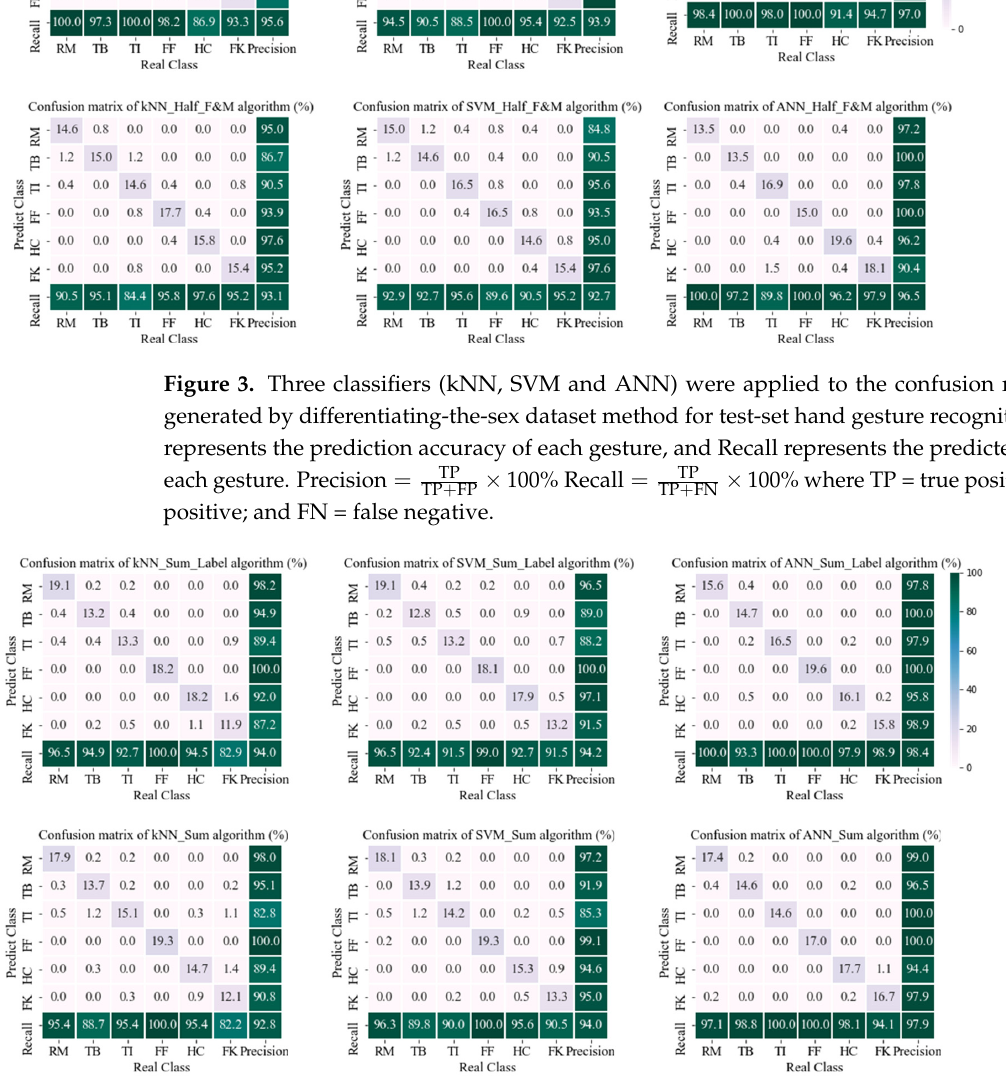
Figure 4. Three classifiers (kNN, SVM and ANN) were applied to the confusion matrix (7 × 7) generated by adding a sex labeling method for test-set hand gesture recognition. Precision represents the prediction accuracy of each gesture, and Recall represents the predicted coverage of each gesture. × 100% Recall = TP × 100% where TP = true positive; FP = false positive; and Precision = TP TP + FP TP + FN FN = false